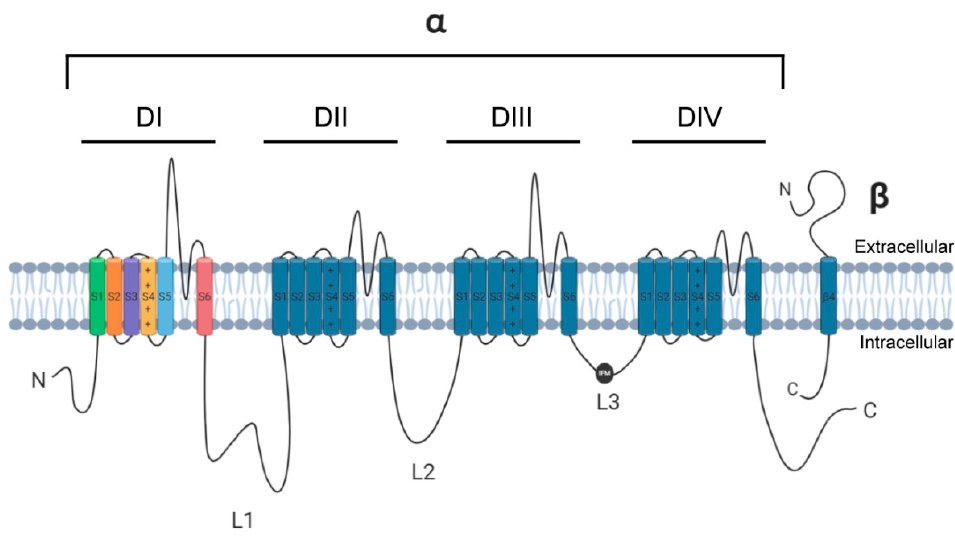
Figure 1. Linear schematic of a voltage-gated sodium channel α subunit and an auxiliary β subunit. L3 depicts the IFM motif (black circle) for channel fast inactivation.